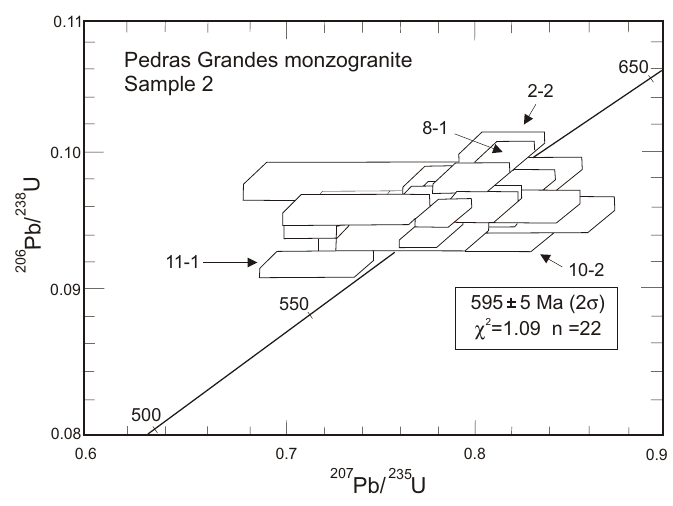
Fig. 5 – Concordia diagram for SHRIMP U-Pb data of 22 zircon grains (26 analyses). Four analyses not included in age calculation are identified (2-2, 8-1, 10-2 and